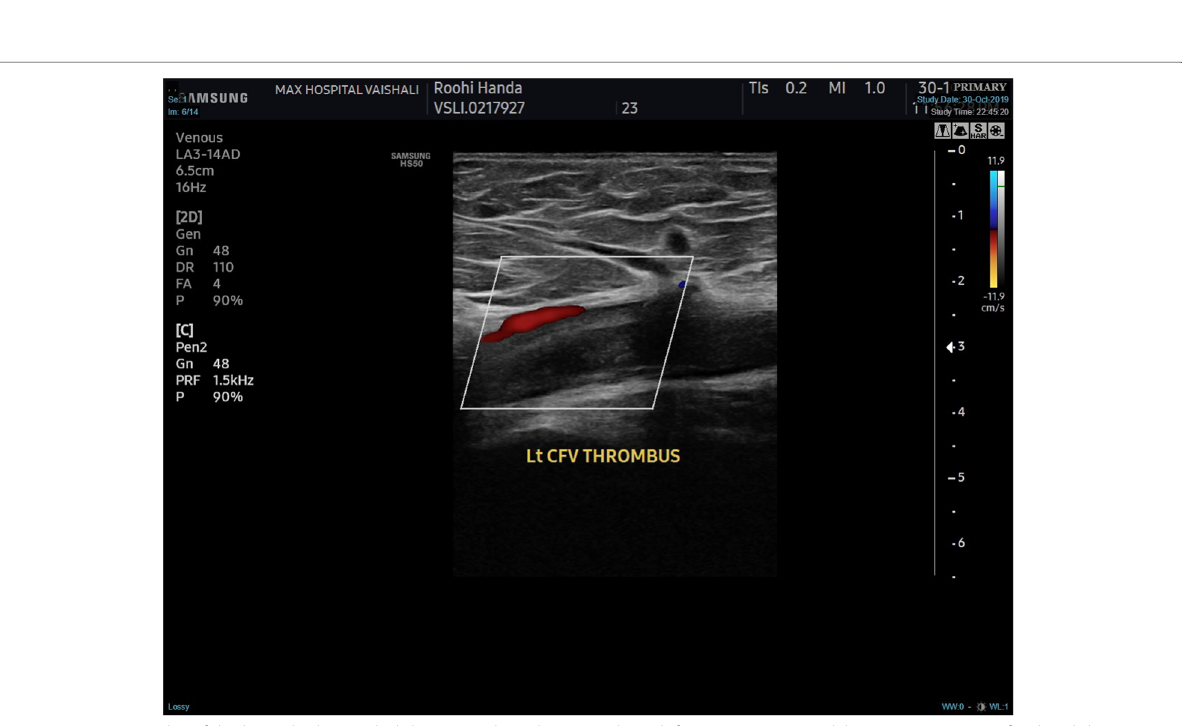
Fig. 4 Venous Doppler of the lower limb revealed deep vein thrombosis involving left common, external iliac, common, superficial and deep femoral, and popliteal veins with